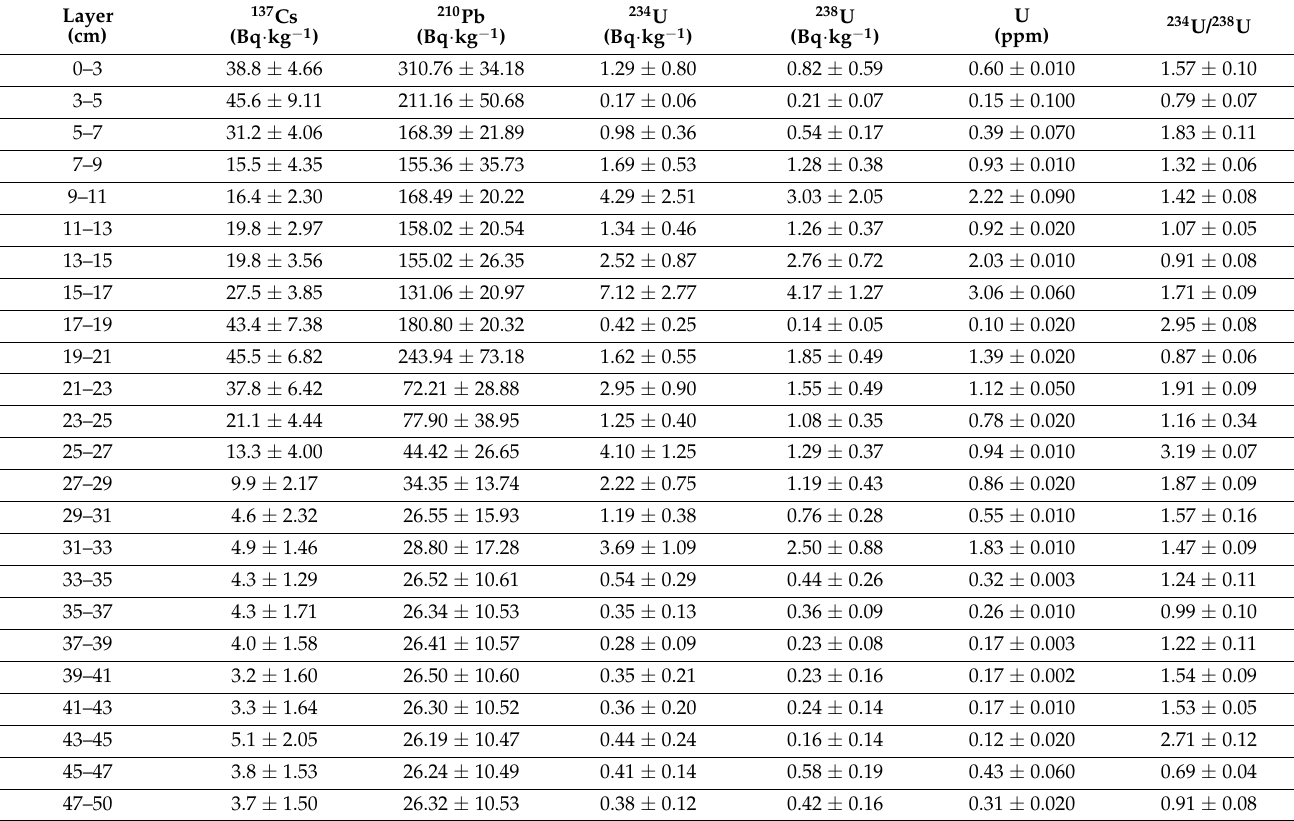
Table A2. Activity concentrations of radionuclides (Bq · kg − 1 ) of the peat